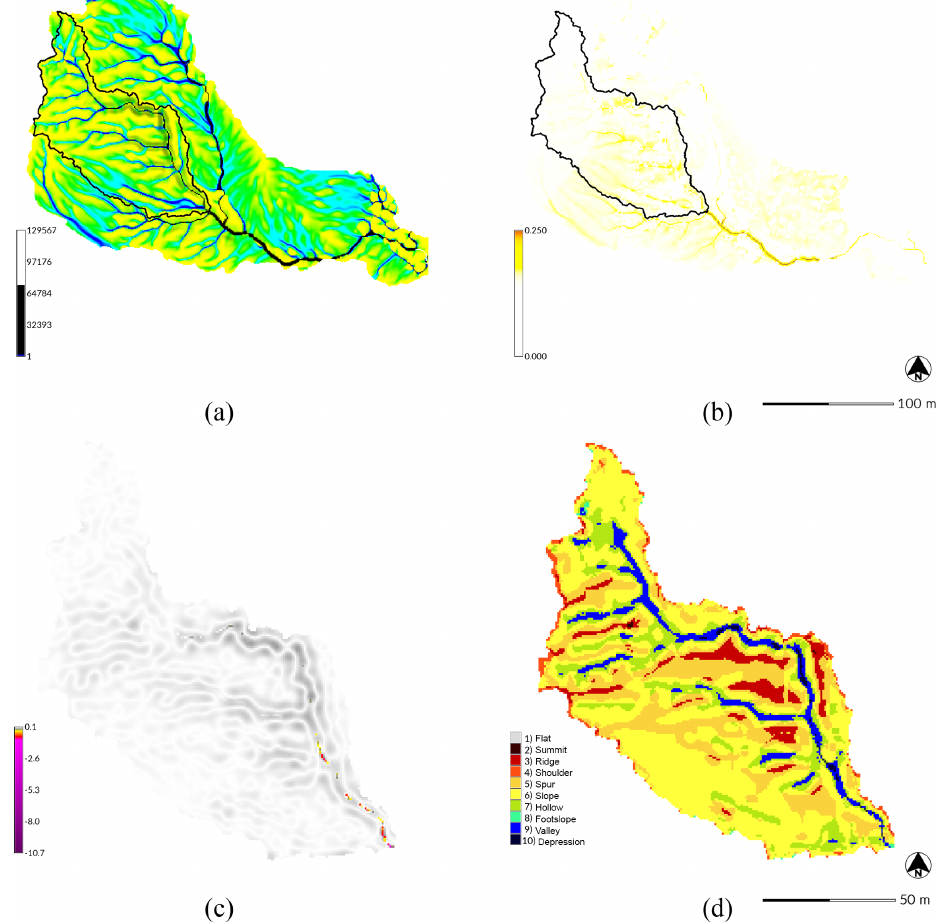
Figure 7. Dynamic simulation with RUSLE3D for a 120min event with a rainfall intensity of 50mmh − 1 for Patterson Branch, Fort Bragg, NC: (a) flow accumulation and (b) erosion [kgm − 2 s − 1 ] for the subwatershed in the final 3min time step; (c) net difference [m] and (d) landforms for drainage area 1. Table 3. Volumetric change. Difference of DEMs